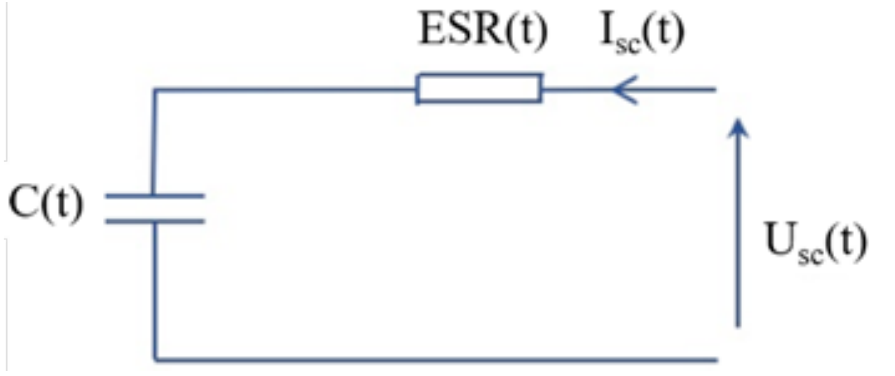
Figure 5. Thevenin electrical model of the SC.